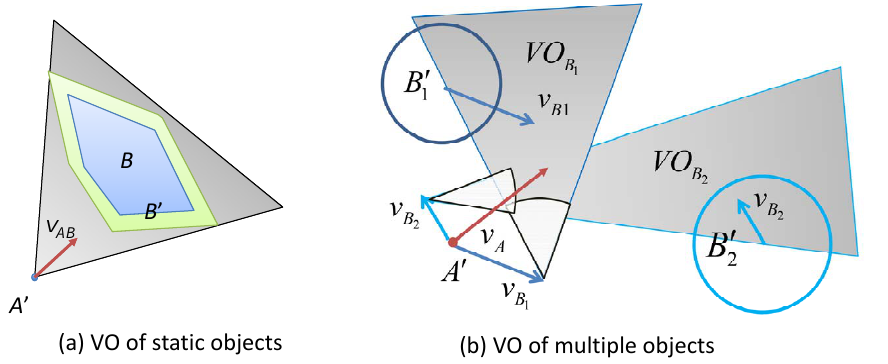
Figure 2. ( a ) VO of static objects; ( b ) illustration of the VO model of multiple mobile objects. B 1 and B 2 are two objects. The shaded areas show VO B